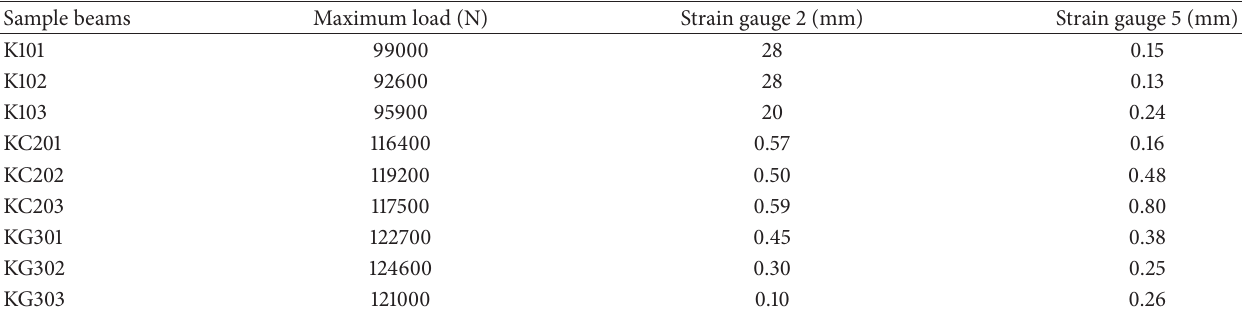
Table 6: Shear cracks against the maximum load in sample beams.